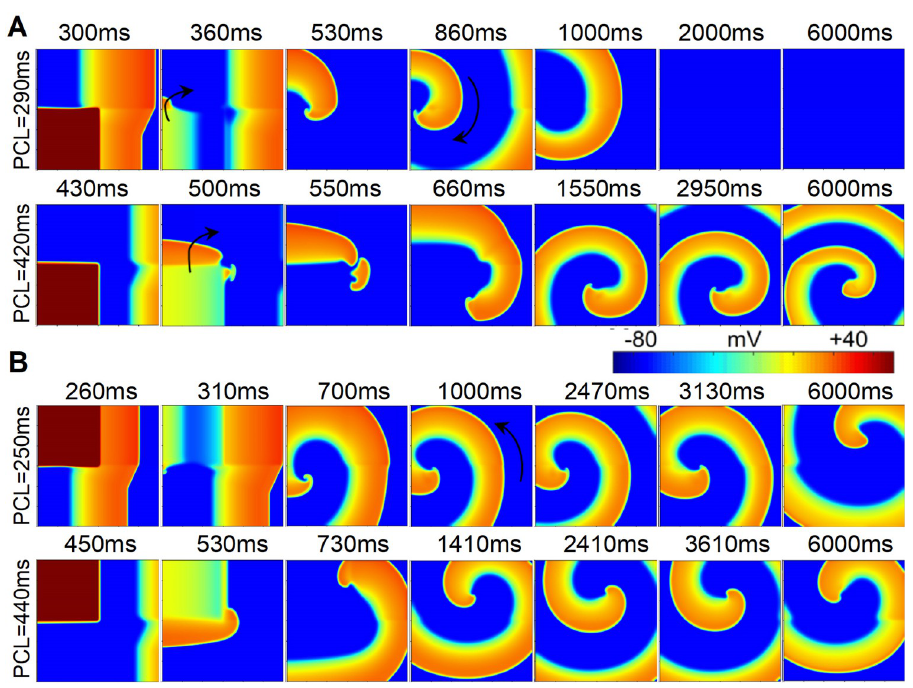
Fig 4. Wave propagation in the 2D tissue (Fig 1Ai, middle panel) where ischemia 1a and decoupled ischemia 1b distributed horizontally using the S1-S2 protocol when the S2 stimulus was applied in the (A) lower left or (B) upper left